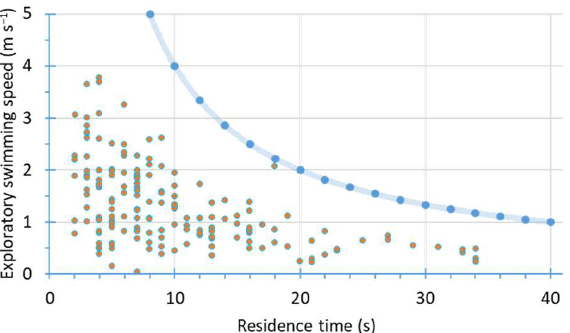
Figure 4. Relationship between the fish school residence time (in seconds) and their exploratory swimming speed (ESS in m s − 1 ). The scatterplot of ESS values versus the residence time showed the effect of a limiting factor, highlighted by the bold curve, which represents the theoretical limits (bold point) of the observations given by the sampling protocol, here a power trend curve of the theoretical function (see, Appendix D).